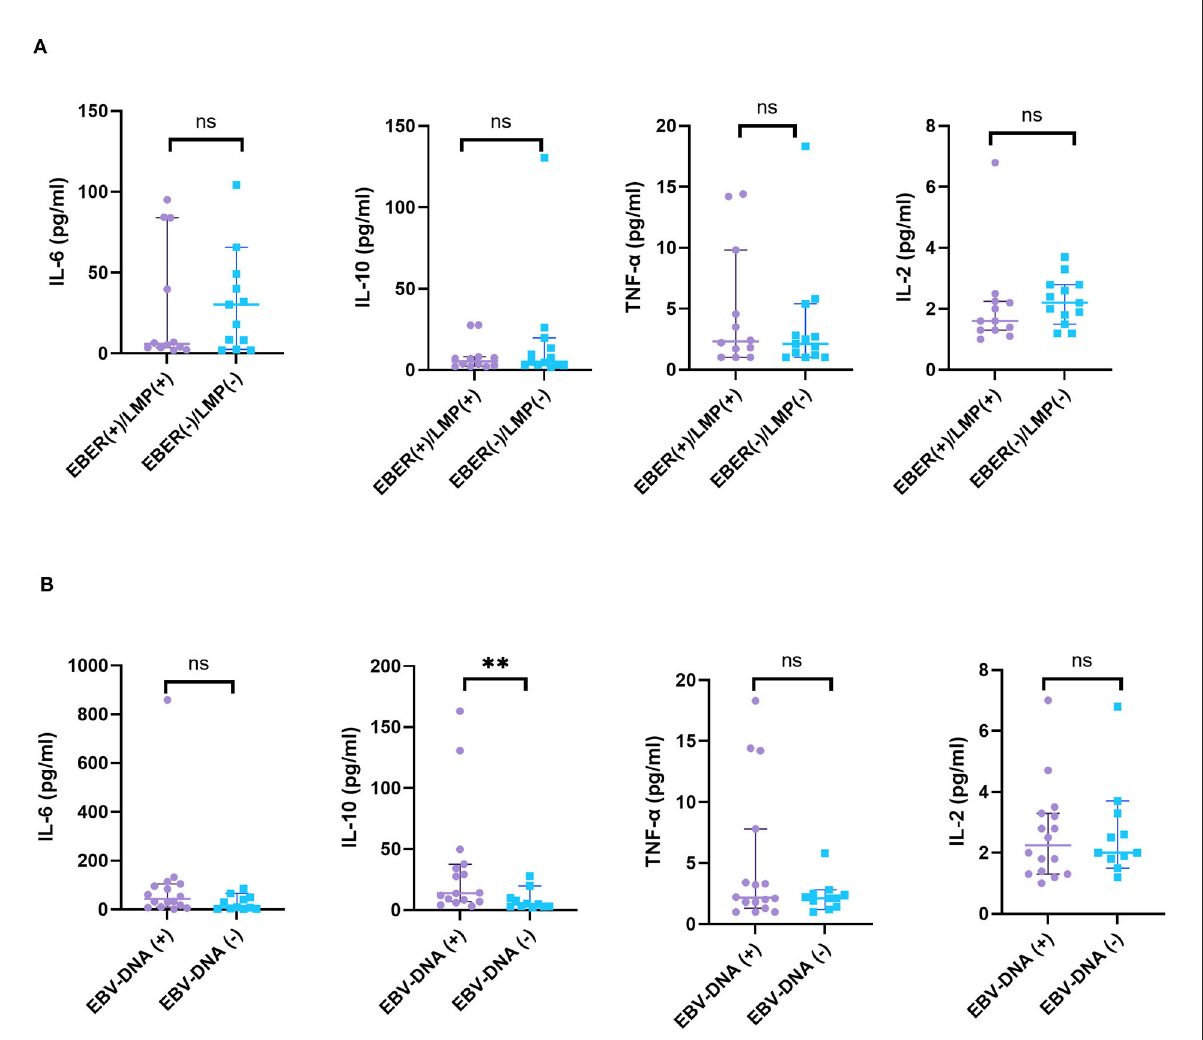
FIGURE6 The relationship between cytokines and EBV infections. (A) A total of 25 patients with HL were grouped according to the expression of EBER or LMP by HRS cells and (B) 27 patients with HL were grouped according to EBV-DNA in blood or bone marrow. ns, not significant, p > 0.05; ** p <